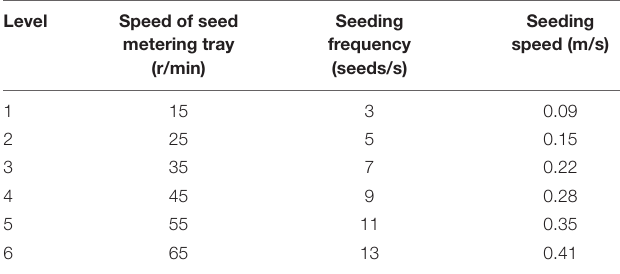
TABLE 3 | Seeding frequency and speed corresponding to the rotating speed of the seed metering tray. Level